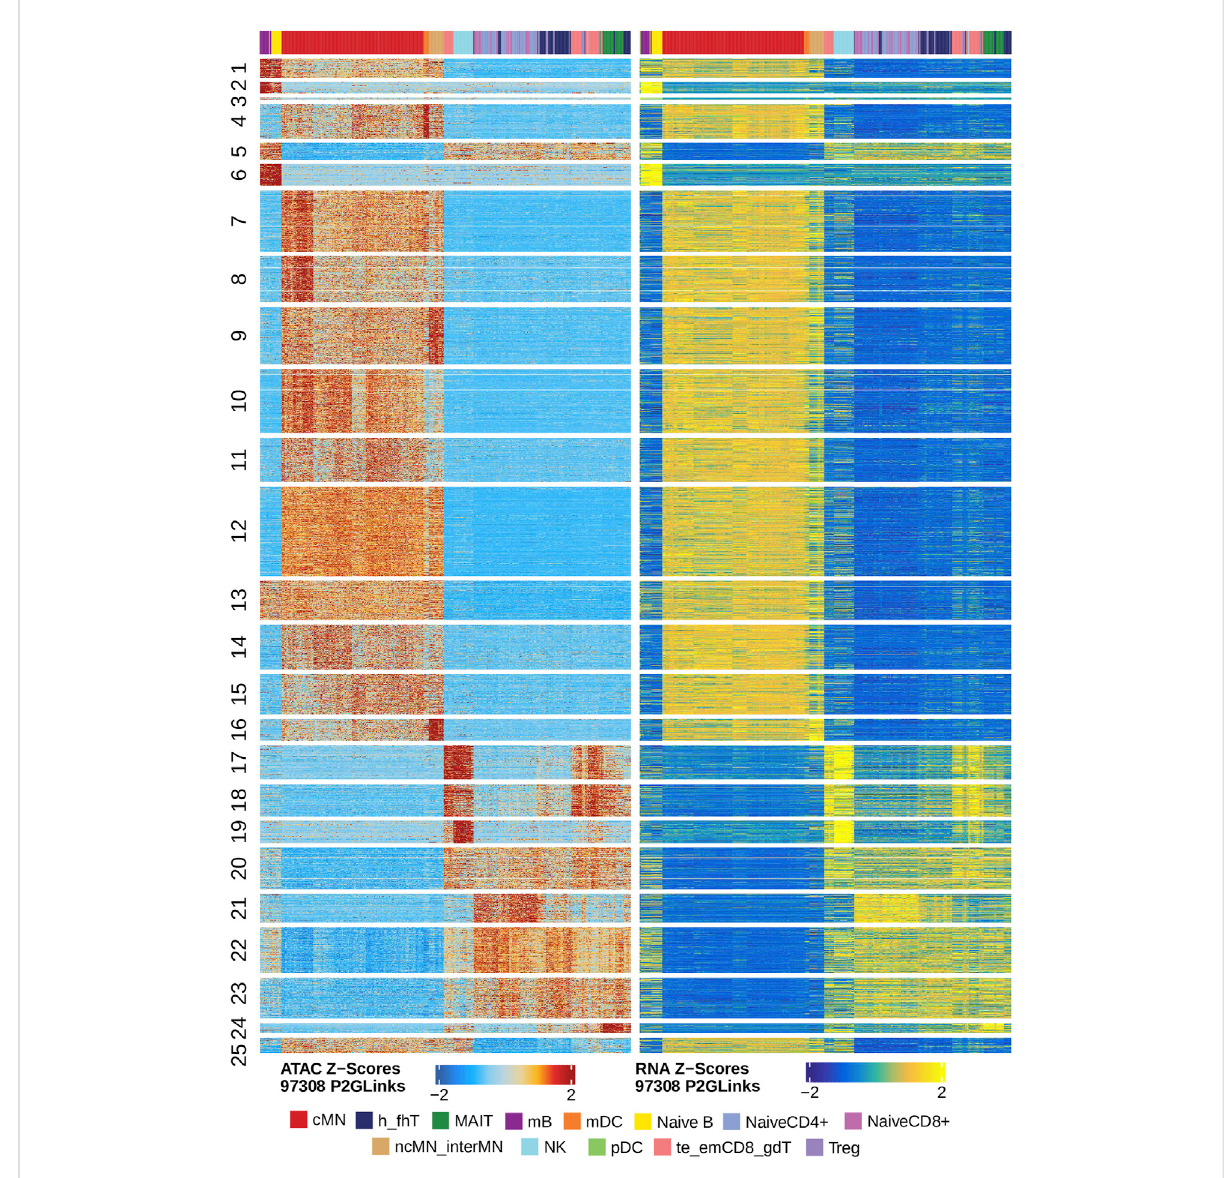
FIGURE 6 Gene scores and pseudo expression of genes linked with peaks are highly consistent in different types of the human PBMCs. Heatmaps on the left and right panels show gene scores (derived from the scATAC-seq data) and pseudo expression (transferred from the scRNA-seq data) of genes linked to the peaks, respectively. Color bars on the top of each heatmap represent the PBMC clusters derived from the scRNA-seq